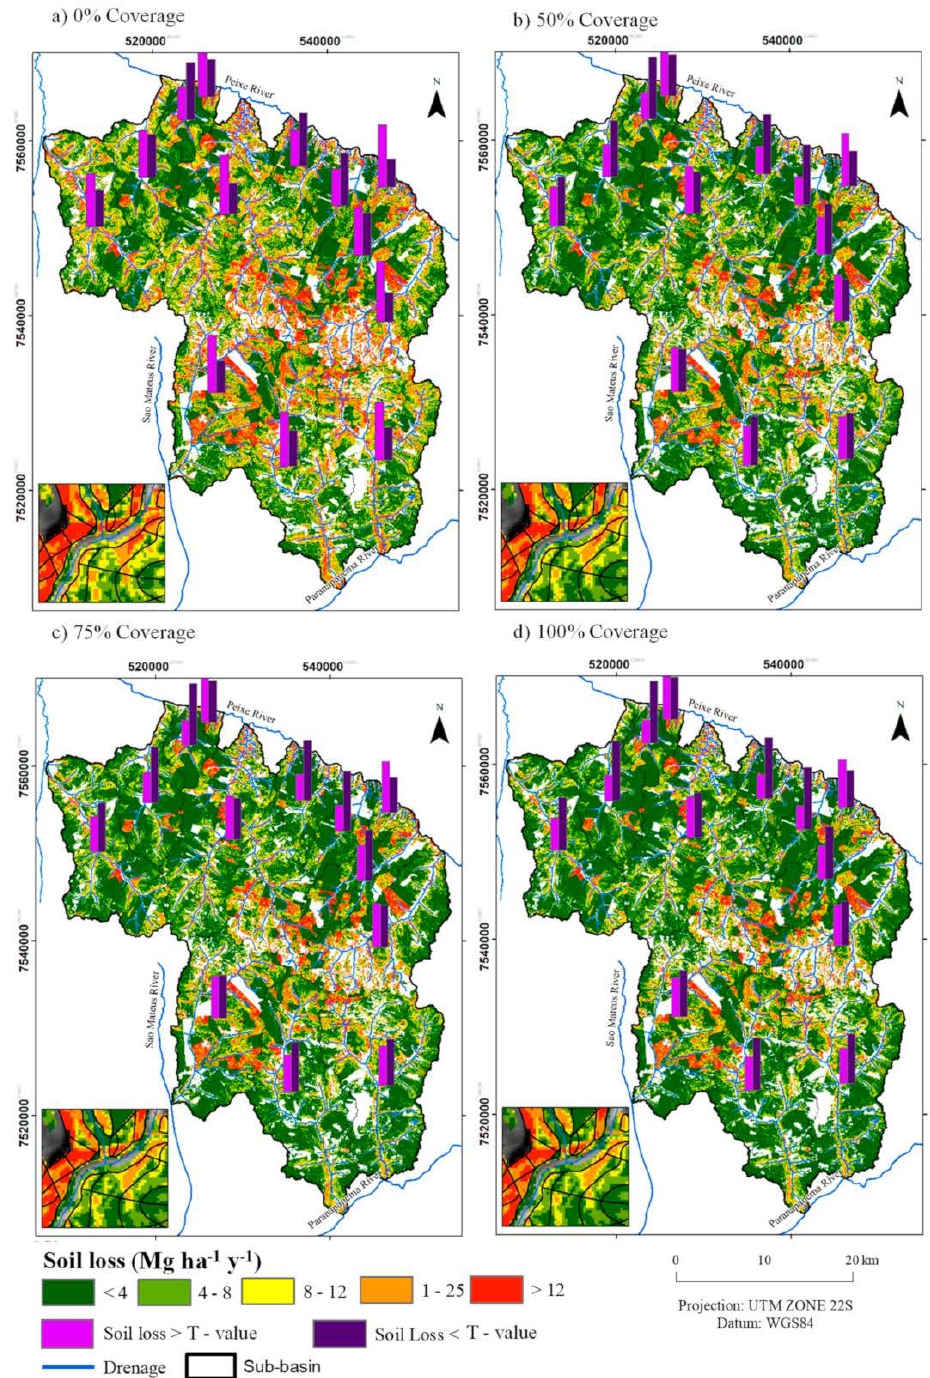
Figure 12. Soil loss obtained by the RUSLE model and the percentage of the basin with greater and lesser soil loss than the tolerance (T-value) with ( a ) 0% straw coverage rate, ( b ) 50% straw coverage, ( c ) 75% straw coverage, and ( d ) 100% straw coverage. The average bulk density of 1.69 Mg m − 3 derived soil loss tolerance (T-value); the T-value presents an area-specific average of 4.3 Mg ha − 1 . Our data demonstrate that the annual average soil erosion exceeds the T-value threshold in 12 of the 13 sub-basins under no cover of straw (Table 6). Sub-basins 3, 6, and 7 show soil loss per percentage of the land lower than the T-value (Figure